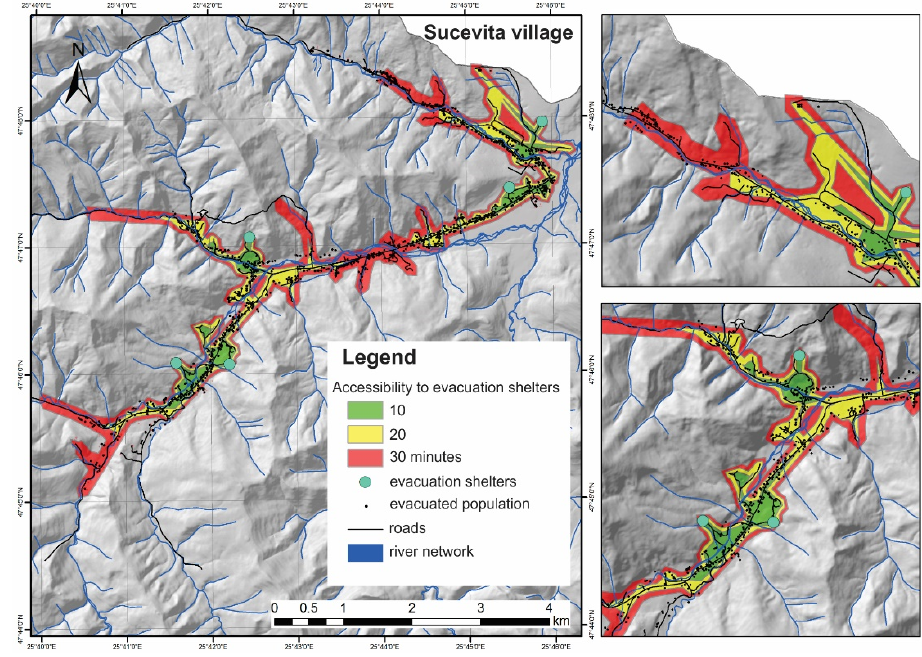
Figure 6. Coverage areas with evacuation service for Sucevi ț a village.